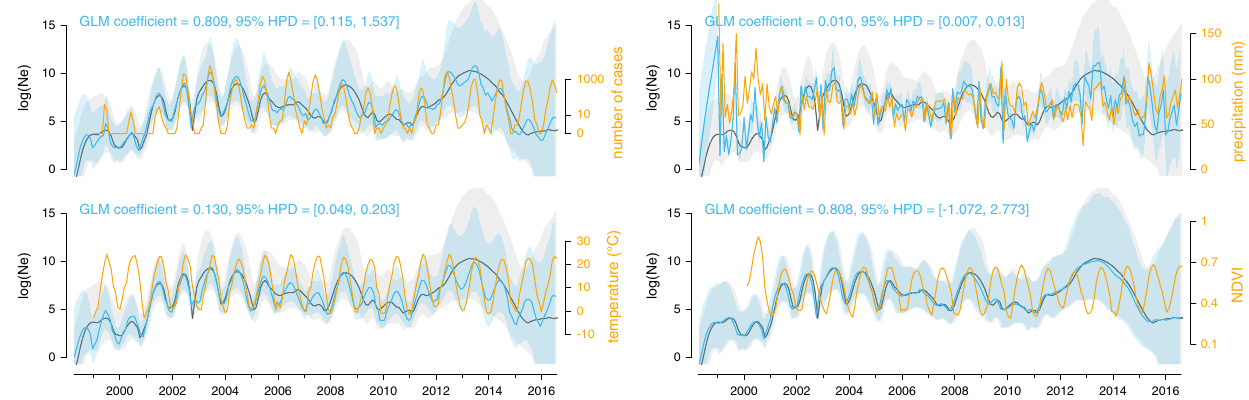
Fig. 5 Associations between viral effective population size and potential covariates. These associations were tested with a generalised linear model (GLM) extension of the coalescent model used to infer the dynamics of the viral effective population size of the virus (Ne) through time. Speci fi cally, we here tested the following time-series variables as potential covariates (orange curves): number of human cases (log-transformed and with a negative time period of one month), mean temperature, mean precipitation, and Normalised Difference Vegetation Index (NDVI, a greenness index). Posterior mean estimates of the viral effective population size based on both sequence data and covariate data are represented by blue curves, and the corresponding blue polygon re fl ects the 95% HPD region. Posterior mean estimates of the viral effective population size inferred strictly from sequence data are represented by grey curves and the corresponding grey polygon re fl ects the 95% HPD region. A signi fi cant association between the covariate and effective population size is inferred when the 95% HPD interval of the GLM coef fi cient excludes zero, which is the case for the case count, temperature, and precipitation